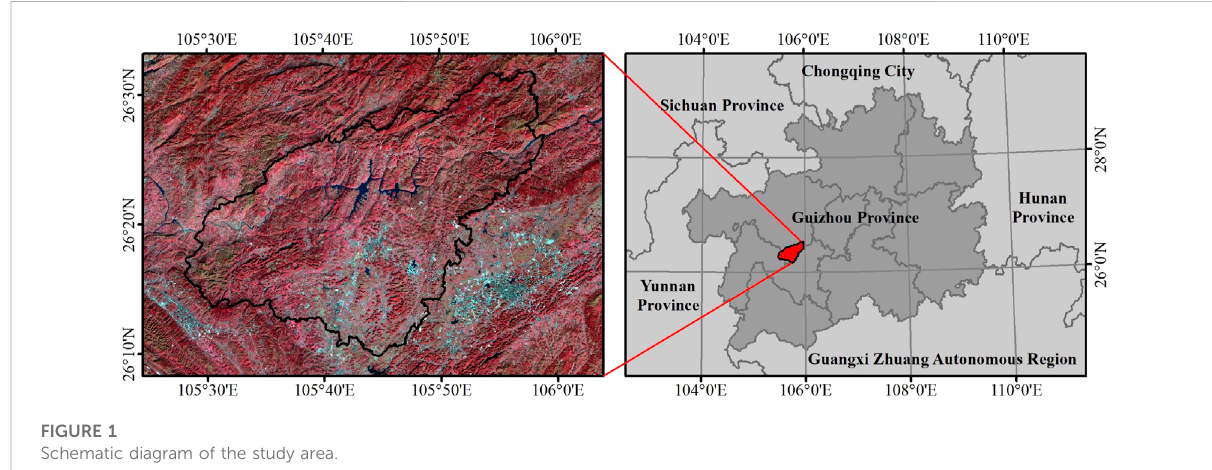
FIGURE 1 Schematic diagram of the study